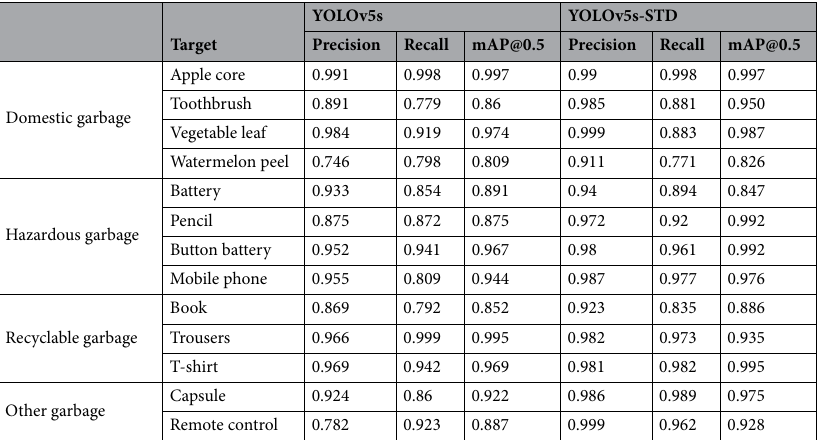
Table 8. Classification accuracy of the proposed YOLOv5s-STD model and YOLOv5s model training garbage dataset.